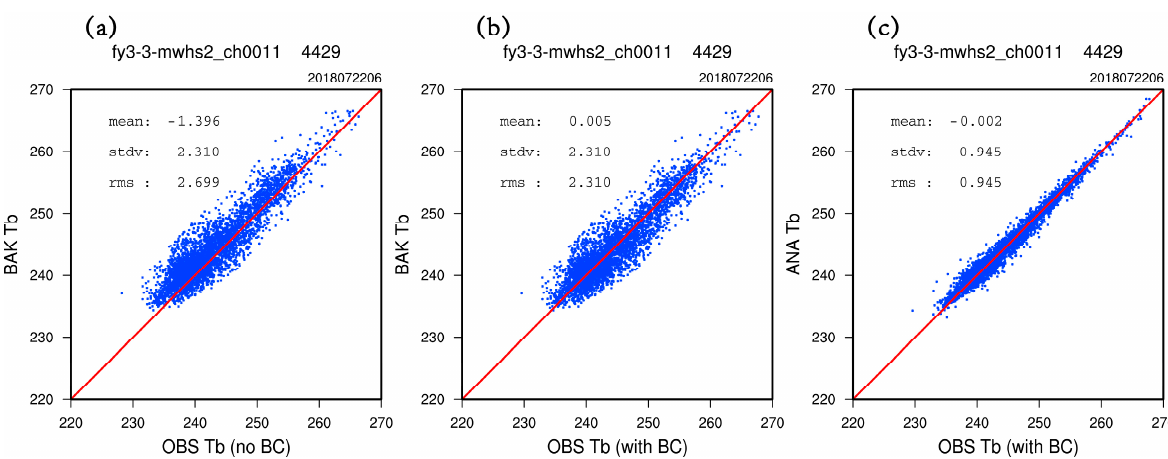
Figure 5. The scatter diagrams of channel 11 observed versus simulated brightness temperature (unit: K) of background ( a ) before the bias correction, ( b ) after the bias correction, and ( c ) observed versus simulated brightness temperature of the analysis.